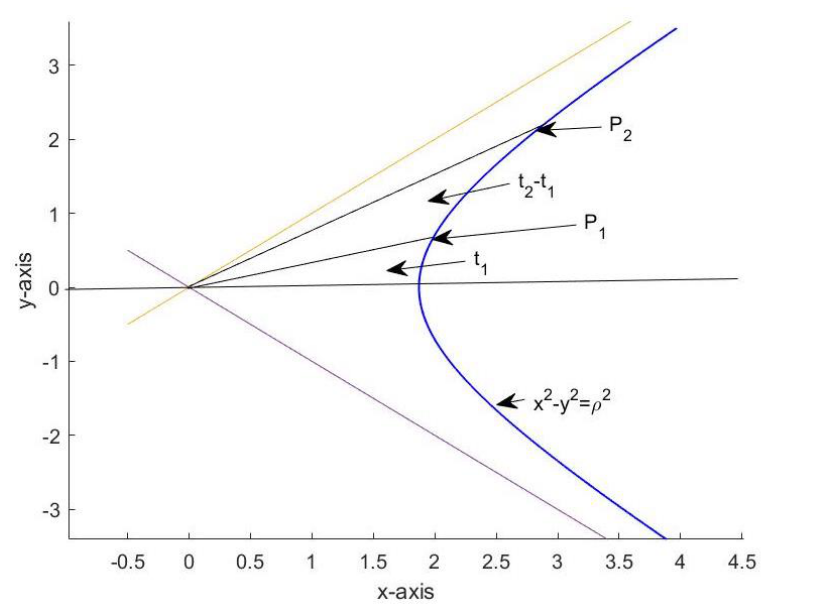
Figure 5. Subtraction of area